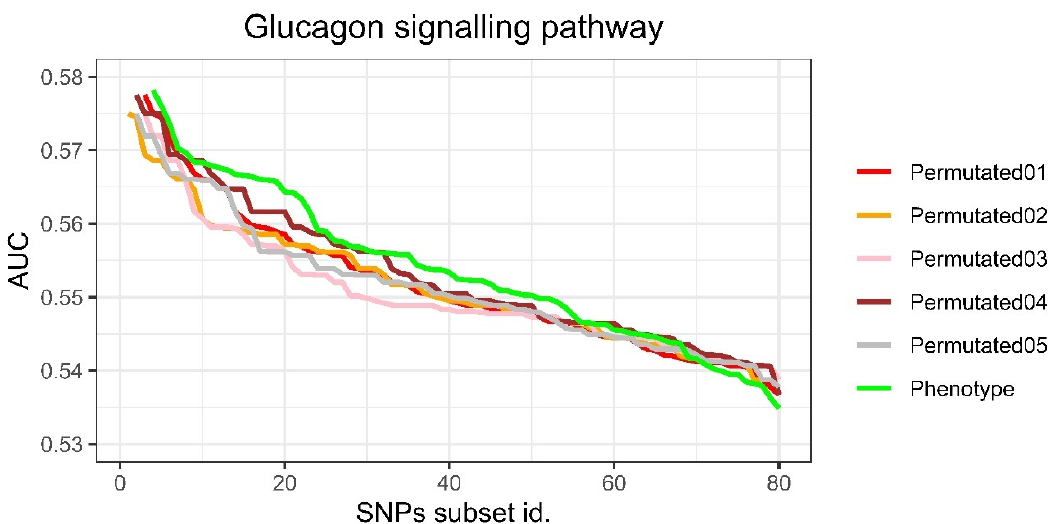
Figure 9. AUC values of the 80 iterations performed for the AMP-activated protein kinase (AMPK) signaling pathway in the case of cases and controls (phenotype) and five different permutations.